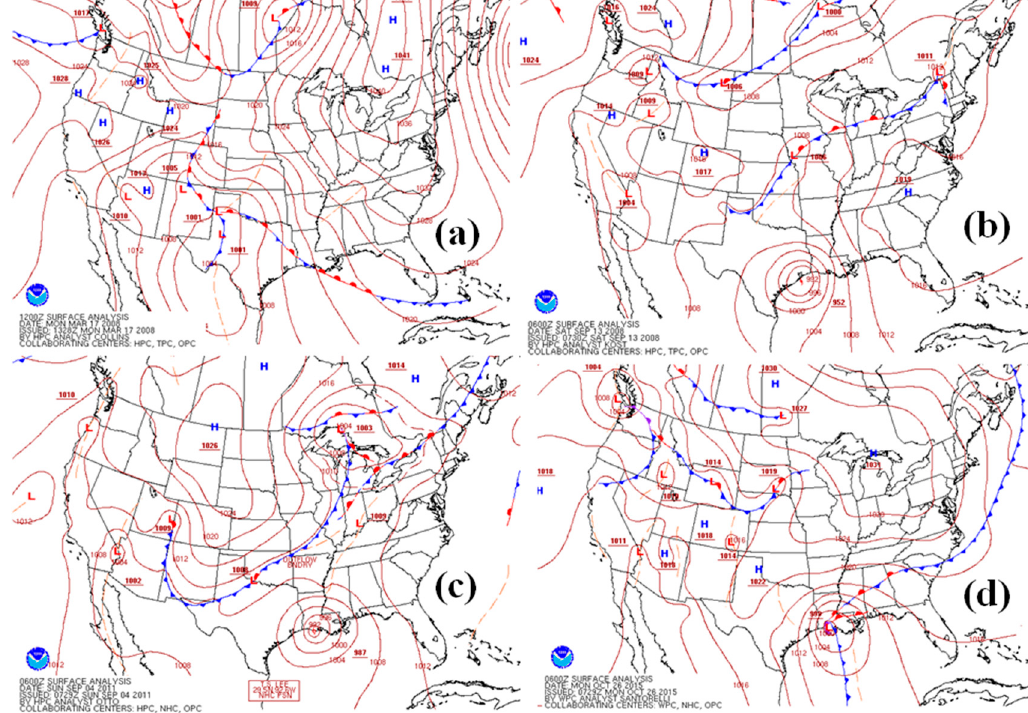
Figure 13. Weather map from NOAA. These maps show the time fronts across the Calcasieu Lake. ( a ) 17 Mar. 2008; ( b ) 13 Sep. 2008; ( c ) 4 Sep. 2011; ( d ) 26 Oct. 2015.